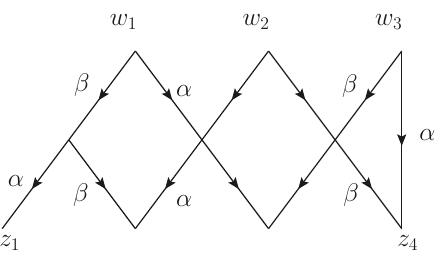
Figure 2 . Diagrammatic representation of the layer operator (cid:3) N =4 ( x ) for open spin chains. The notations are the same as in (cid:12)gure 1, the vertices imply integration with the measure (2.19). for homogeneous spin chains, for closed as well as open ones, were constructed in [35,